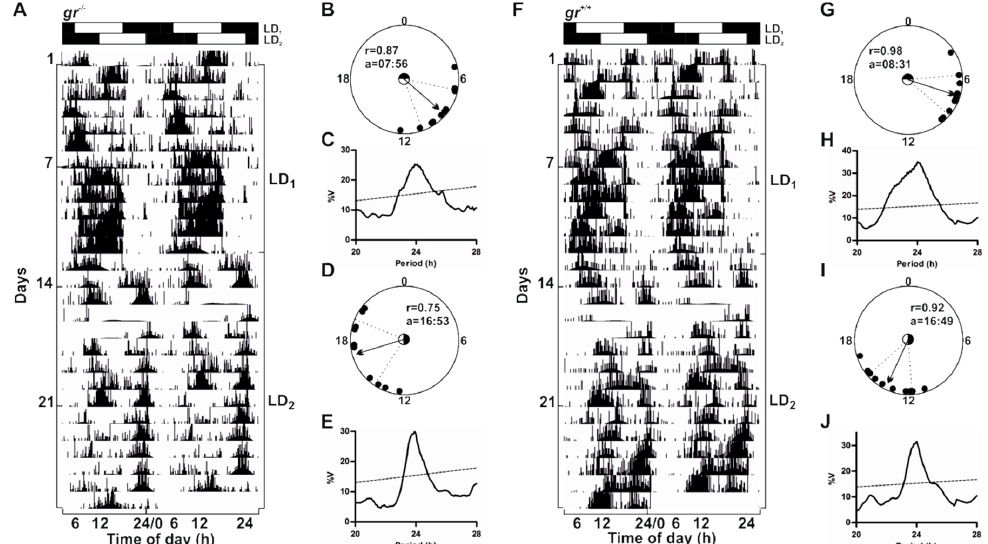
Figure 5. Daily activity rhythms of gr +/+ and gr − / − adult zebrafish. Representative actograms ( A , F ), circular diagrams ( B , D , G , I ) and χ 2 periodogram analysis ( C , E , H , J ) of adult zebrafish gr +/+ and gr − / − subjected to 12:12 LD cycles. In actograms the height of each point represents the number of infrared light-beam interruptions in 10 min. Starting and ending day of each LD cycle (LD 1 and LD 2 ) is shown on the right of the actogram. The number of days is indicated on the left and the time of day is plotted on the bottom of each actogram. For more details, see Figure 2. Circular diagrams showing acrophases for the last 10 days of each LD period are plotted ( B , D , G , I ). Each black dot shows the daily acrophase, while arrows indicate the average acrophase represented as a vector. In each circle the mean vector length (r) and mean acrophase (a) are shown ( B and D for gr − / − ; G and I for gr +/+ , for LD 1 and LD 2 , respectively). The circle inside each circular diagram represents critical values of the Rayleigh test ( p < 0.05) and the black part of the circle shows the duration of dark phase. The dotted lines represent the confidence intervals. Activity records in the last 10 days of each LD cycle were also subjected to χ 2 periodogram analysis ( C and E for gr − / − , H and J for gr +/+ ). Confidence limits were chosen at the 99% level.